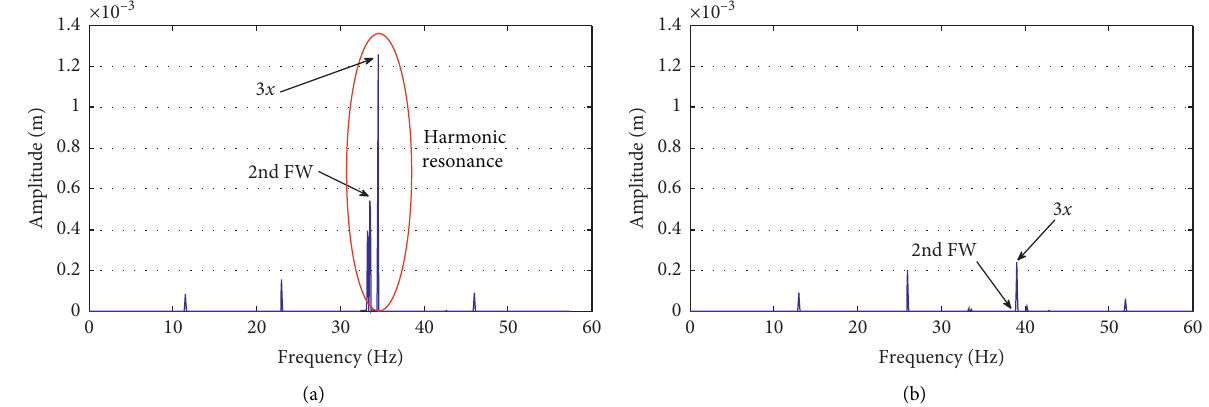
Figure 15: Resonance of 3 x in the vertical direction of bearing 1: (a) 11.5 Hz and (b) 13 Hz.